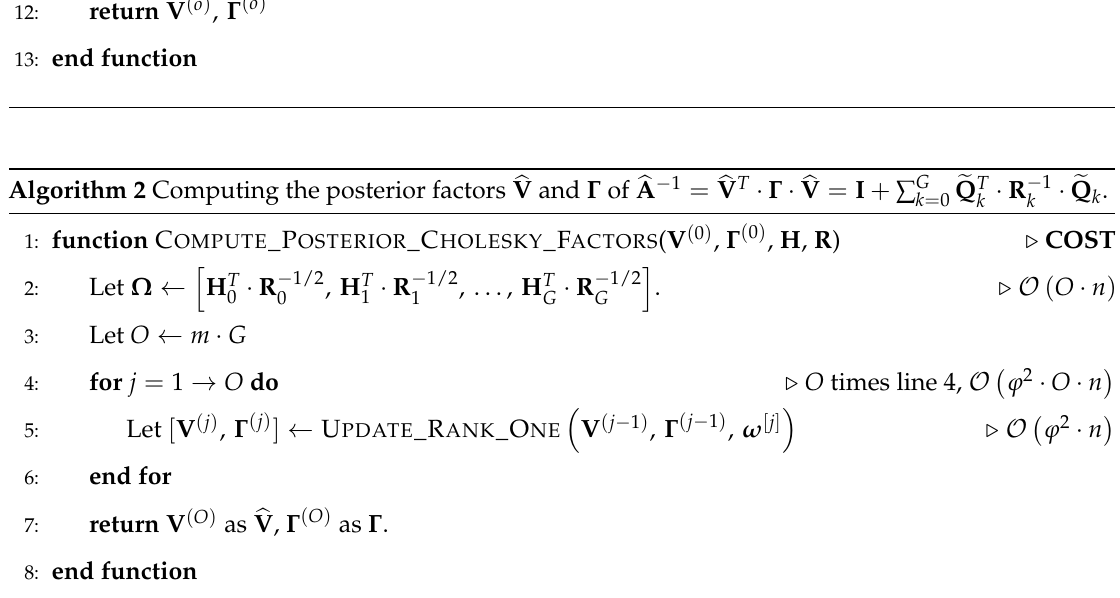
· R − 1 · (cid:101) Q Q T k k = 0 (cid:101) k k